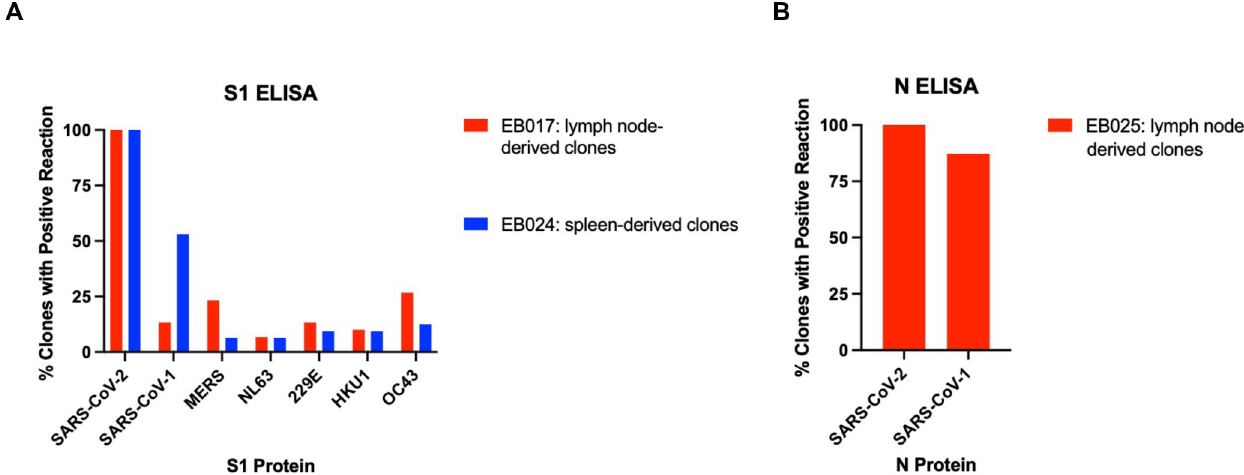
Fig 1. Binding of SARS-CoV-2 S1 and N mAbs. mAb clones were harvested from the hybridomas of SARS-CoV-2 spike subunit (S1) or nucleocapsid (N) immunized mice. (A) ELISA using hybridoma supernatants from the lymph nodes of mouse EB017 or the spleen of mouse EB024, both of which were infected with SARS-CoV-2 S1. Hybridoma supernatants were tested with S1 from SARS-CoV-2, SARS-CoV-1, MERS, NL63, 229E, HKU1, and OC43 to evaluate cross-reactivity. B) ELISA using hybridoma supernatants from the lymph nodes of mouse EB025 infected with SARS-CoV-2 N. Hybridoma supernatants were tested with S1 from SARS-CoV-2 and SARS-CoV-1 to evaluate cross-reactivity. Cross rection for both ELISAs is measured by % clones that demonstrated a positive reaction, or an OD 50 greater than or equal to 5 times the standard deviation of the blank signal intensity.